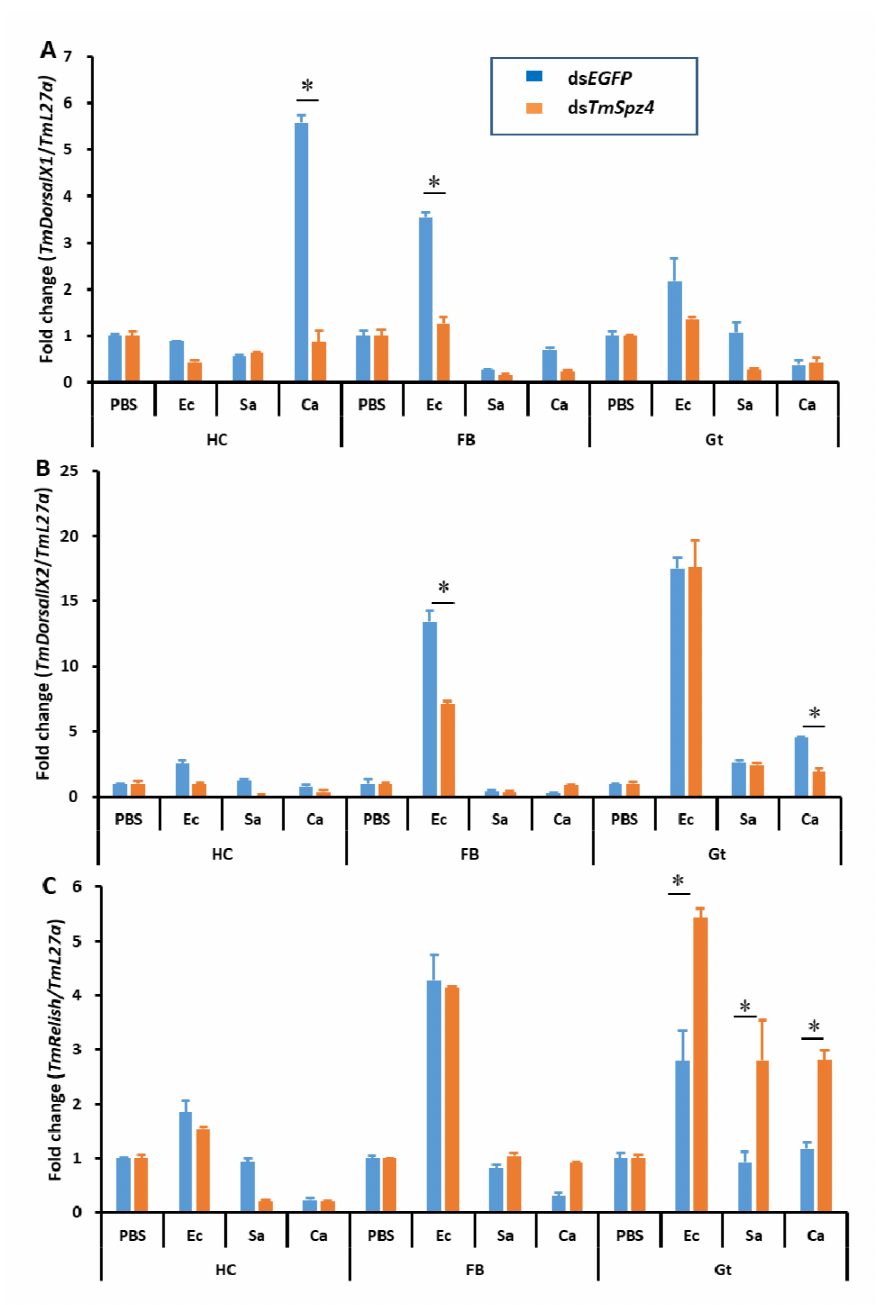
Figure 8. E ff ect of Tmspz4 gene silencing on expression of NF- κ B genes. Three di ff erent pathogens, E. coli , S. aureus , and C. albicans , were injected into TmSpz4 -silenced T . molitor young larvae, and the expression of the NF- κ B genes TmDorX1 ( A ), TmDorX2 ( B ), and TmRel ( C ) were then investigated by RT-qPCR. Larvae were injected with ds EGFP as a negative control, and TmL27a expression was assessed as an internal control. All experiments were performed in triplicate. Asterisks indicate significant di ff erences in NF- κ B gene expression between the ds TmSpz4- and dsEGFP- treated groups when compared by Student’s t-test ( p <